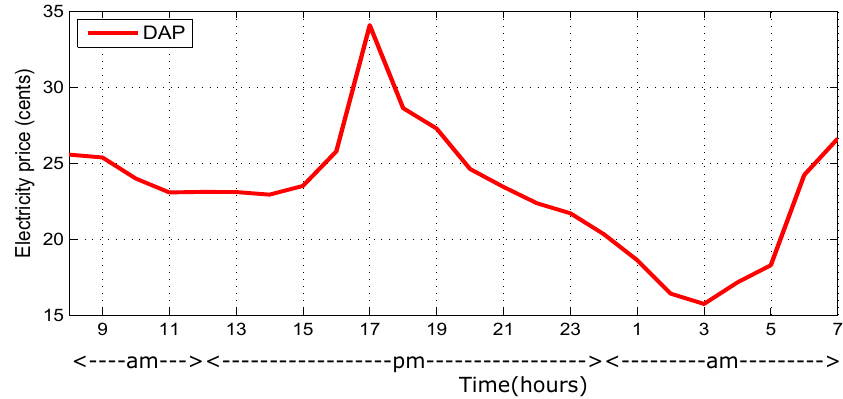
Figure 2. Day-ahead pricing (DAP) reproduced signal [32].